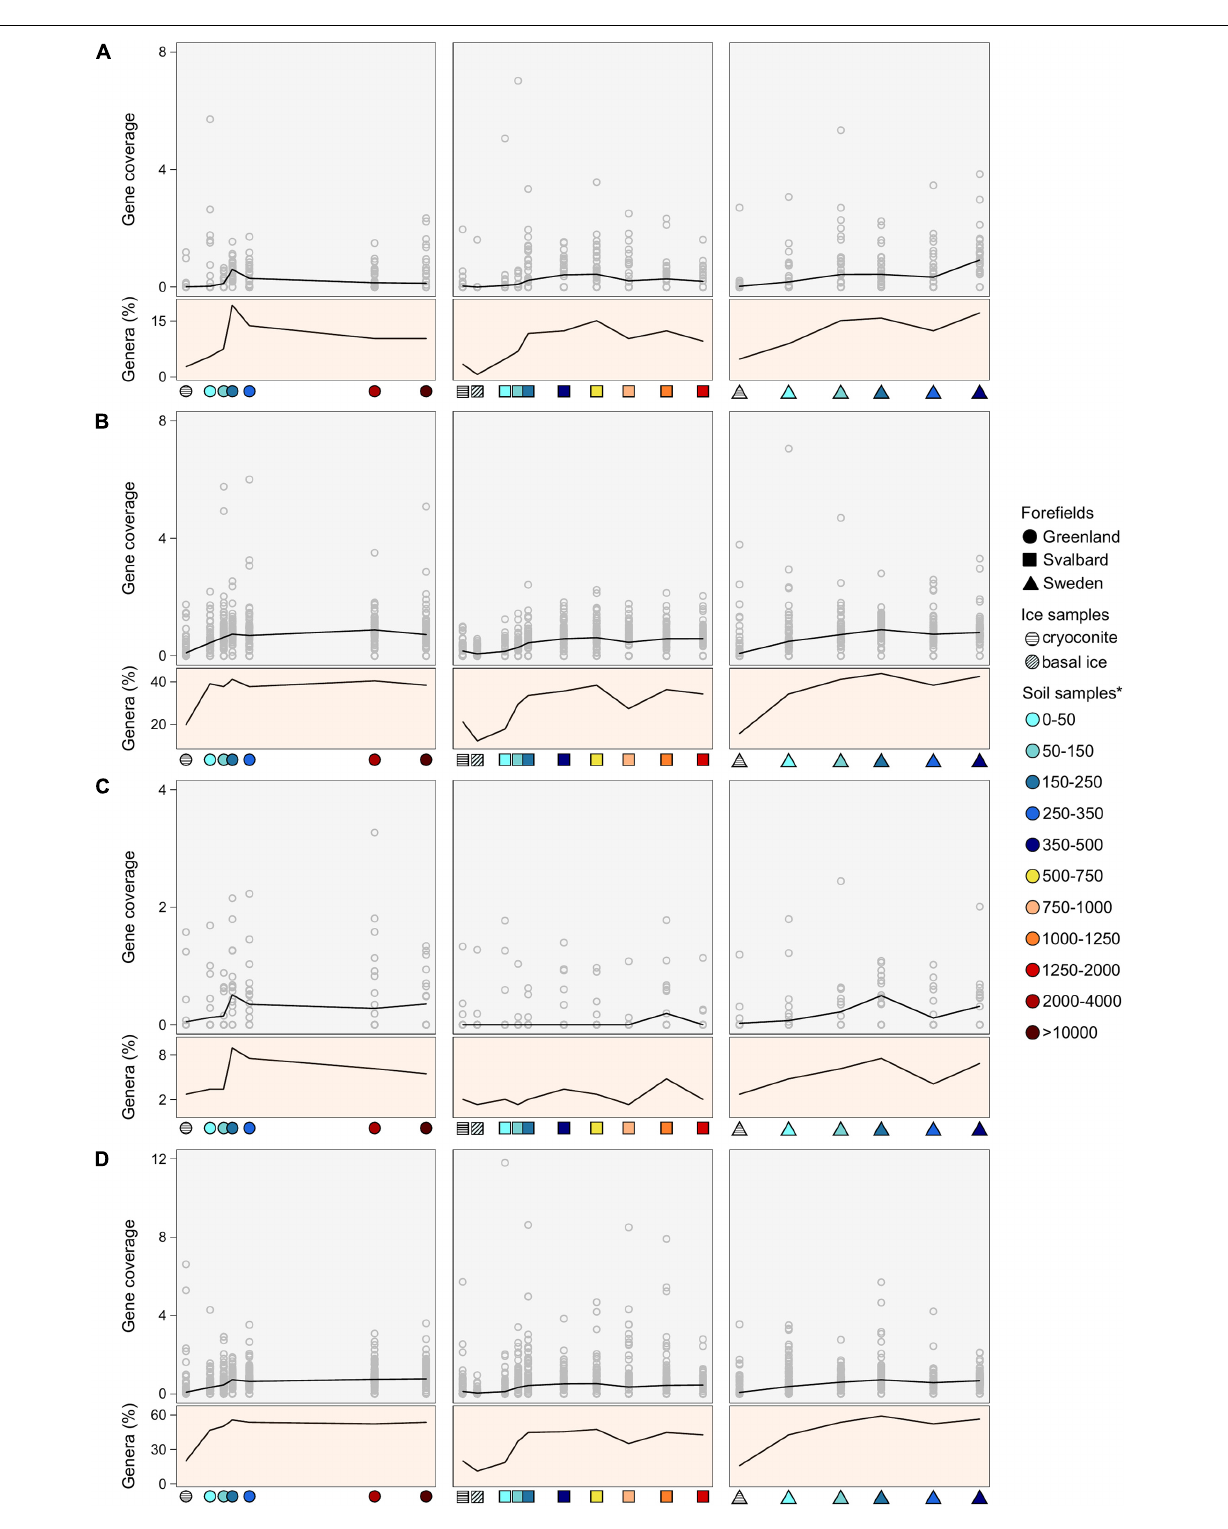
Frontiers in Microbiology |